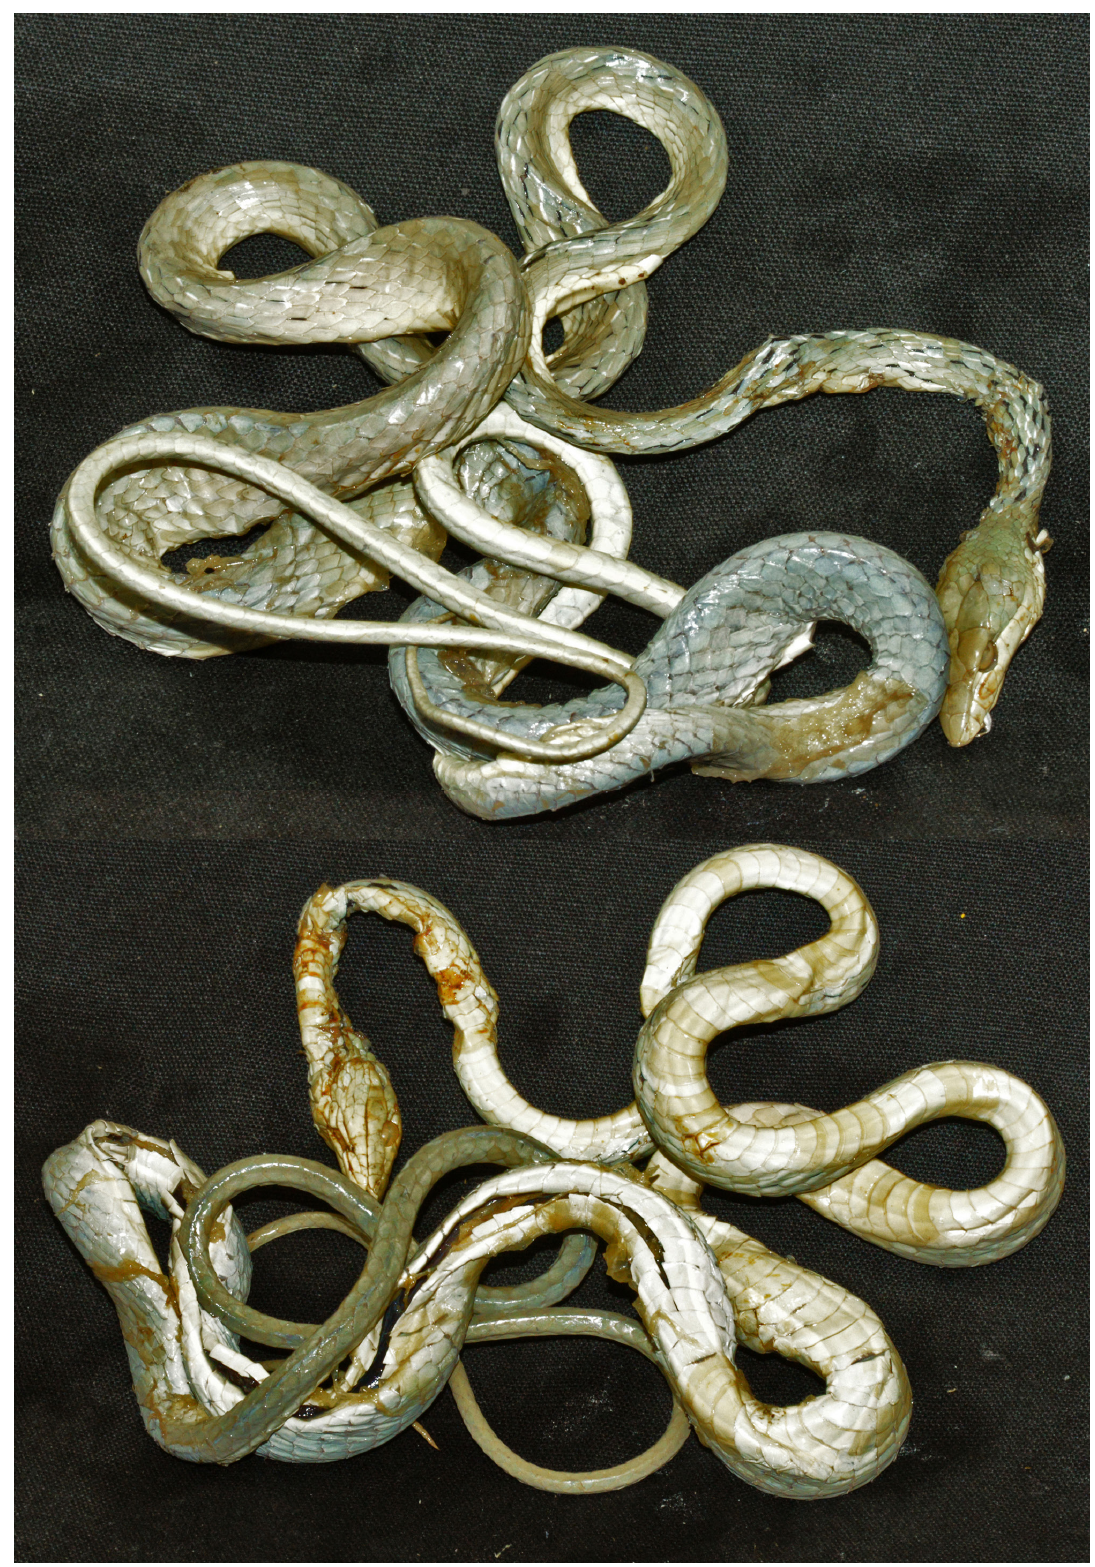
Fig. 3. Dryophis prasinus var . flavescens Wall, 1910, lectotype (NHMUK 1908.6.23.58). Entire profile, dorsal and ventral views. Photo: © The Trustees of the Natural History Museum,